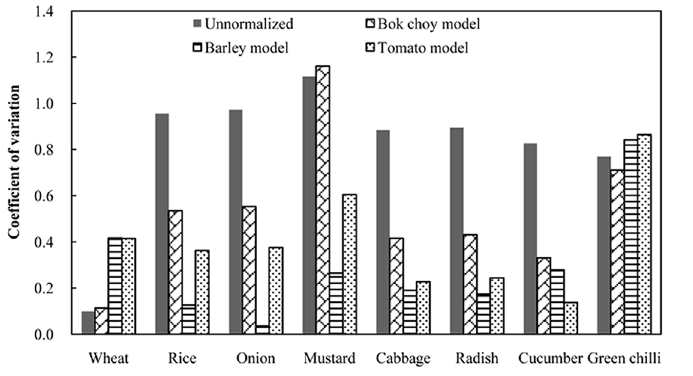
Fig 3. Intra-species variability of Cu EC50 values.